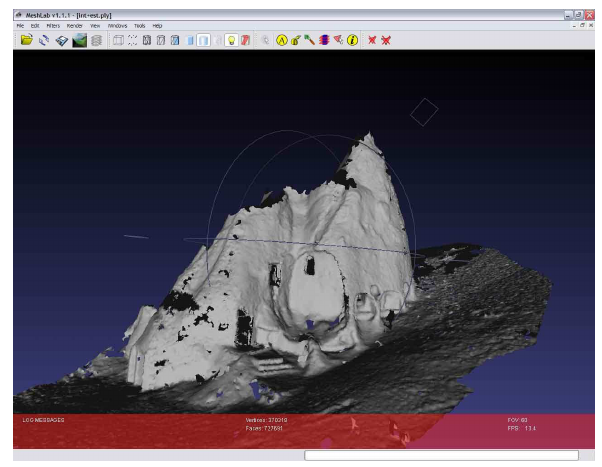
Figure 2. Türkei, Sahinefendi, XL Martyrs Church, Laser Scanning, M. Carpiceci 2007.